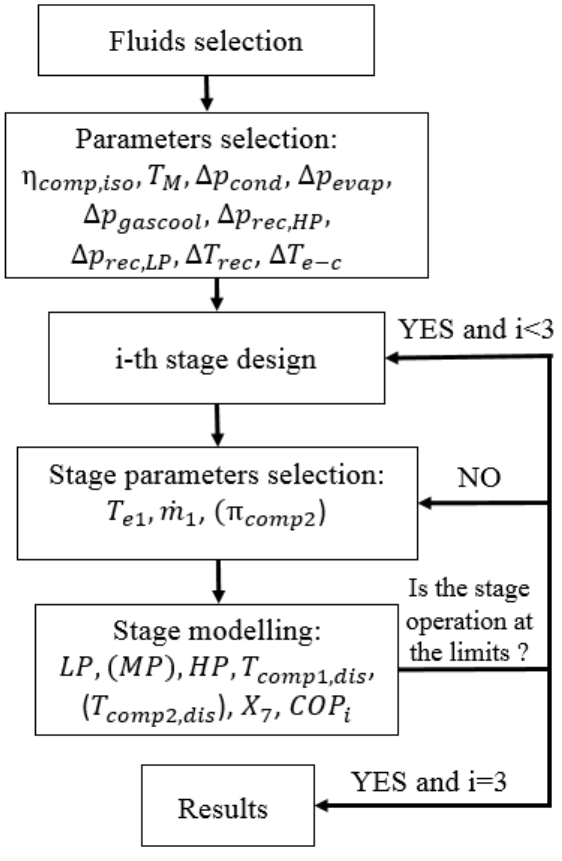
Figure 6. Modeling